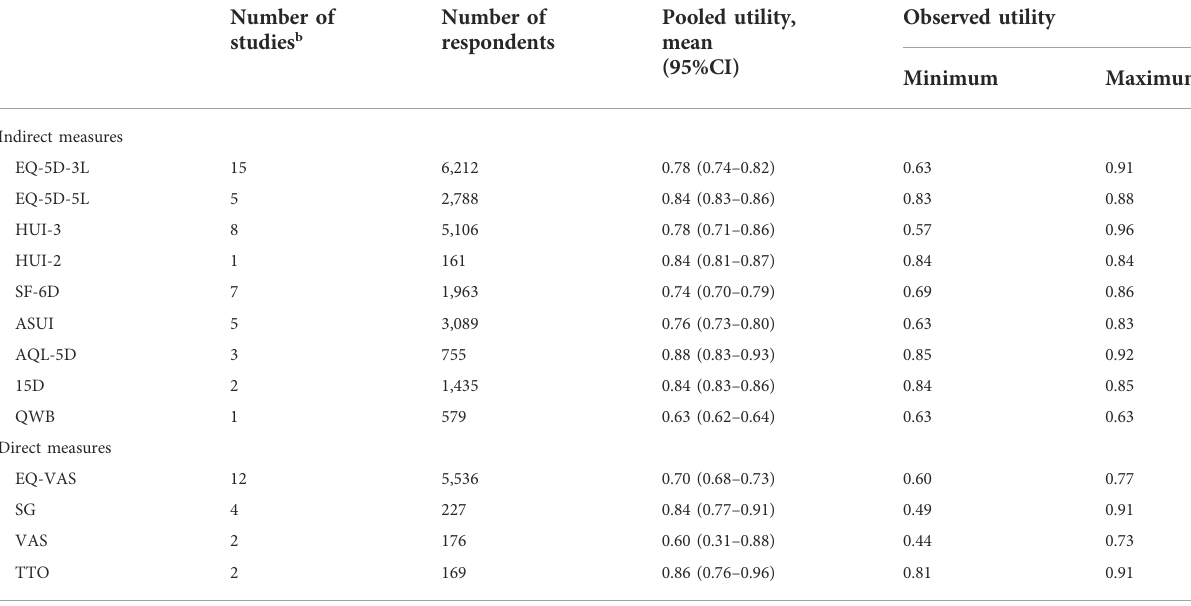
TABLE 2 Results of random effects meta-analyses for asthma utility a strati fi ed by utility